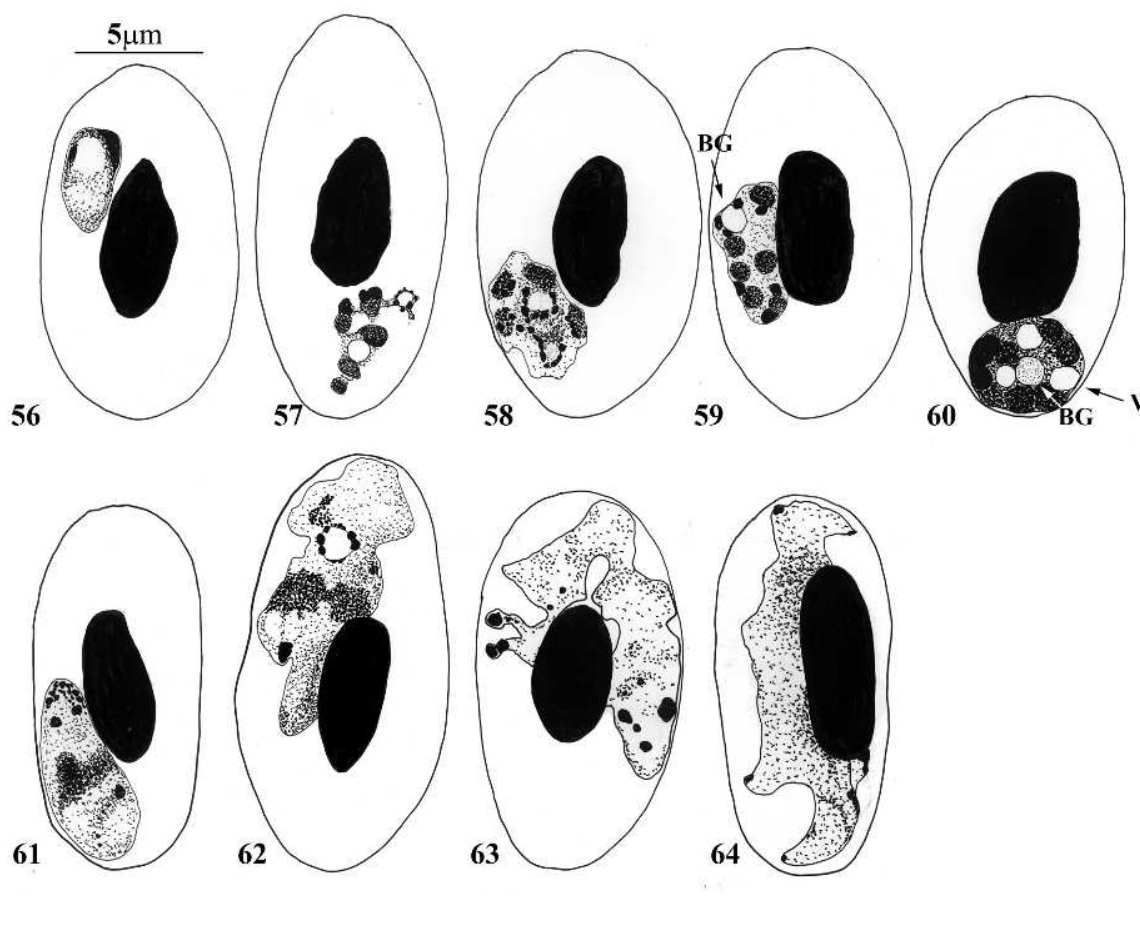
1-18. – Plasmodium alloelongatum n. sp. from Accipiter brevipes . All schizogony stages (Figs 1-9) in premature erythrocytes. Figs 1-3: undivided schizonts. Fig. 4: dividing schizont. Fig. 5: schizonts of four to six nuclei. Figs 8, 9: mature schizont with elongated merozoites. Fig. 10: young macrogametocyte. Figs 11-13: macrogametocytes. Figs 14-18: microgametocytes. Same scale for all figures. Figs 19-28. – Plasmodium accipiteris n. sp. from Accipiter brevipes . Fig. 19: young schizont;y. Figs 20-22: schizonts after 1 st division. Figs 23- 26: schizonts of four to six nuclei. Fig. 27: macrogametocyte. Fig. 28: microgametocytes. BG = blue staining globule. Same scale for all figures. Figs 29-55. – Plasmodium. buteonis n. sp. from Buteo buteo . Fig. 29: trophozoite. Figs 30, 31: early schizonts. Fig. 32: young schizonts, already elongated. Fig. 33: trophozoite (top) and five-nucleate schizont. Fig. 34: schizont with nine nuclei. Figs 35, 36: multiple infections of schizonts and gametocytes. Figs 37-44: further stages in schizont’s differentiation – elongation and nuclei multiplication. Fig. 45: schi- zonts of ~20 nuclei. Fig. 46: schizont of ~ 36 nuclei. Figs 47-50: macrogametocytes. Figs 51-53: microgametocytes. Fig. 54: triple infection: from top-macrogametocyte, young schizont and 16-nucleated schizont. Fig. 55: double infection of eight-nucleate schizont (right) and macro- gametocyte. P = pigment; t = trophozoite. Same scale for all figures. Figs 56-64. – Plasmodium sp. from Buteo buteo . Fig. 56: trophozoite. Fig. 57: reticulated schizont. Figs. 58-60: clumped, rounded schizonts. Fig. 61: young macrogametocyte. Fig. 62: mature macrogametocyte. Figs 63, 64: microgametocytes. BG = blue staining globule; V = vacuole. Same scale for all figures. Figs 65-68. – Plasmodium alloelongatum n. sp. from Accipiter brevipes . Figs 65, 66: schizonts. Fig. 67: macrogametocyte. Fig. 68: micro- gametocyte. Figs 69, 70. – Plasmodium accipiteris n. sp. from Accipiter brevipes . Fig. 69: schizont. Fig. 70: macrogametocyte. Figs 71-79. – Plasmodium. buteonis n. sp. from Buteo buteo . Figs 71, 72: multiple infections with young schizonts. Figs 73, 74: on-growing schizont. Fig. 75: mature schizont. Fig. 76: macrogametocyte. Figs 77, 78: microgametocytes. Fig. 79: double infection of macrogametocyte and schizont. Figs 80-83. – Plasmodium sp. from Buteo buteo . Fig. 80: reticulated schizont. Fig. 81: clumped, rounded schizont. Fig. 82: macrogameto- cyte. Fig. 83: